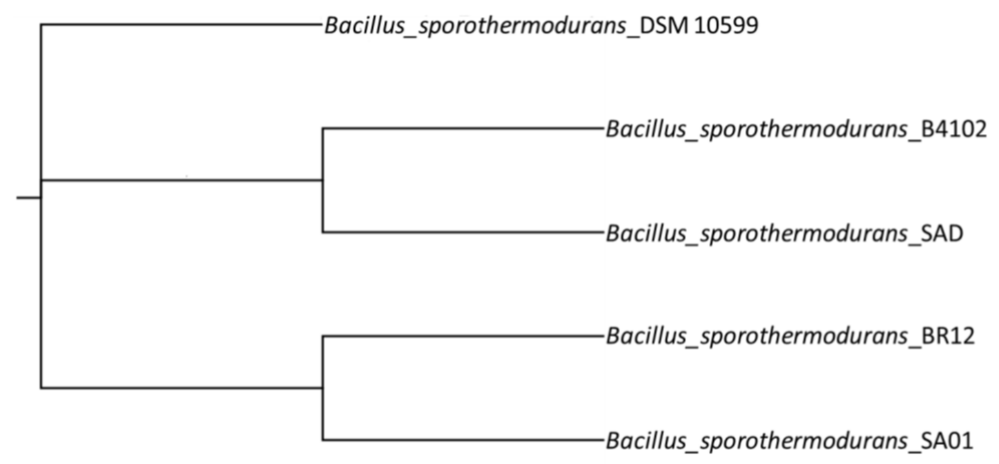
Figure 3. Single nucleotide polymorphism (SNP) analysis showing the phylogeny of the five B. sporothermodurans strains SAD, SA01, BR12, DSM 10599, and B4102, with type strain DSM 10599 as reference. The phylogenetic tree was derived from the Newick files of CSI phylogeny and processed with FigTree.